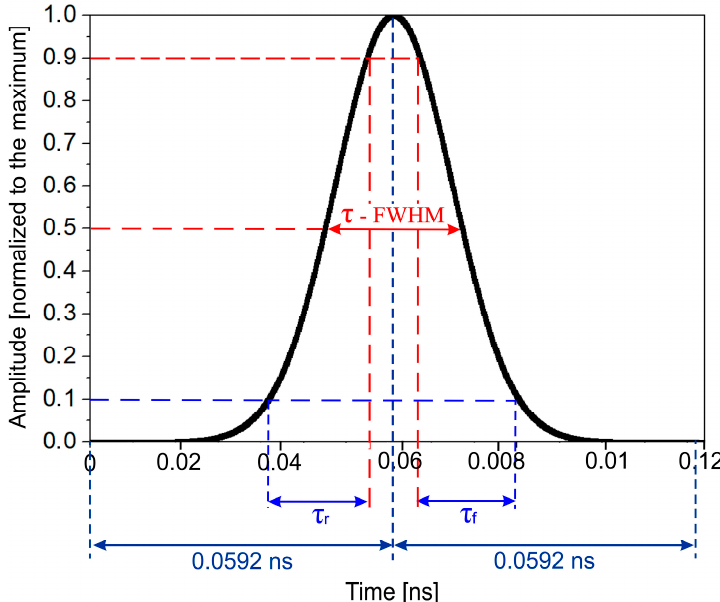
Figure 2. The normalized amplitude of the electric field strength (or the magnetic field strength) of the incident Gaussian EM plane wave as a function of time.